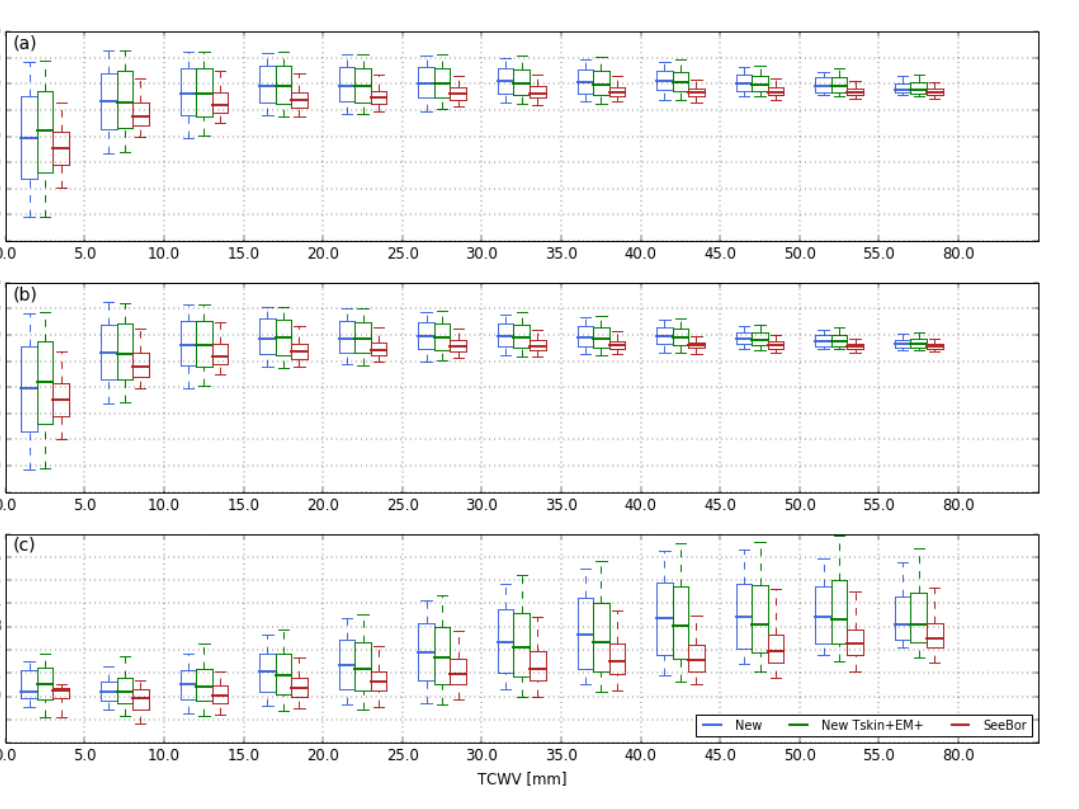
Figure 11. Distribution of the TOA brightness temperature at ( a ) ~11 µm (BT11), and ( b ) ~12 µm (BT12), and ( c ) respective difference between the two, for each TCWV class. The bold line represents the median, the box represents the 25th to 75th percentiles, and the whiskers represent the 5th and 95th percentiles. Values are shown for the new calibration database with a single Tskin and emissivity value per profile (blues), for the new database with extended Tskin and emissivity values (Tskin+EM+; green) and the SeeBor database (red).